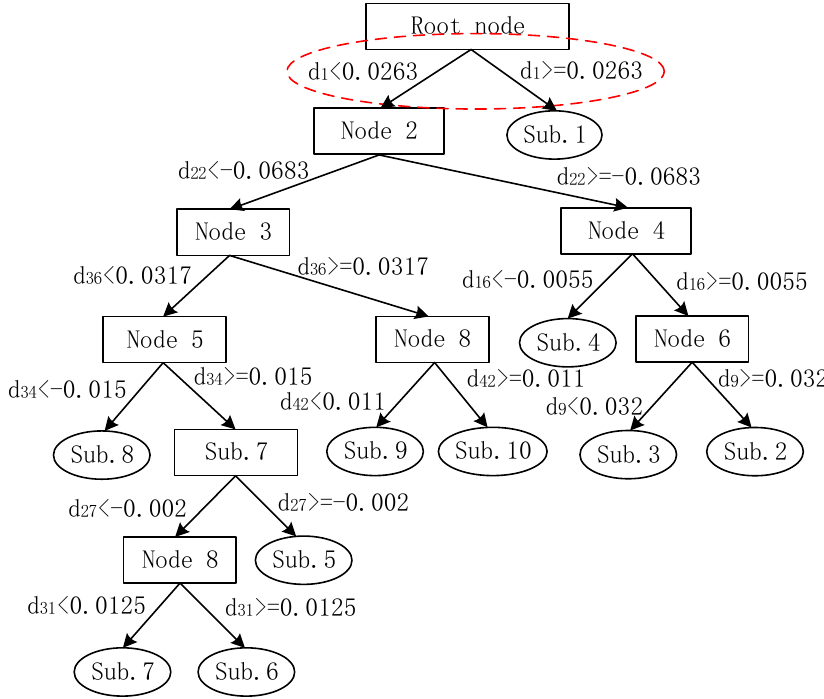
Figure 10. The CART for distinguishing different subspaces of operating point. Table 3. Cases from subspaces test